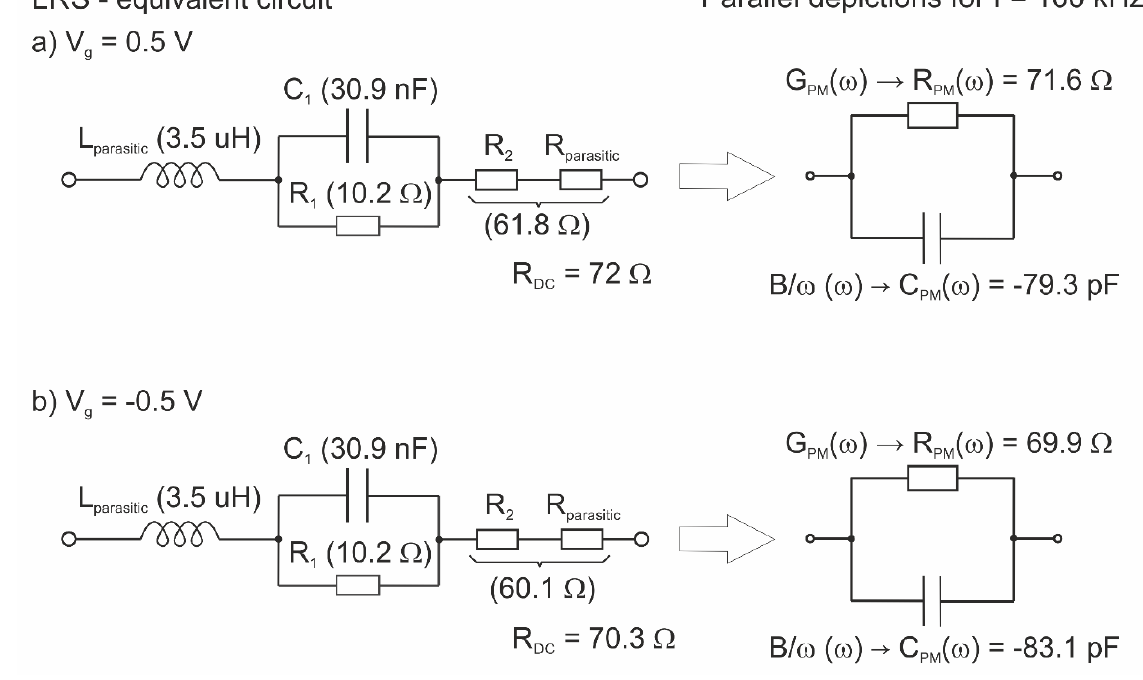
Figure 10. Electrical equivalent circuit for the measured device in LRS at two bias points, ( a ) V g = 0.5 V; ( b ) V g = - 0.5 V.